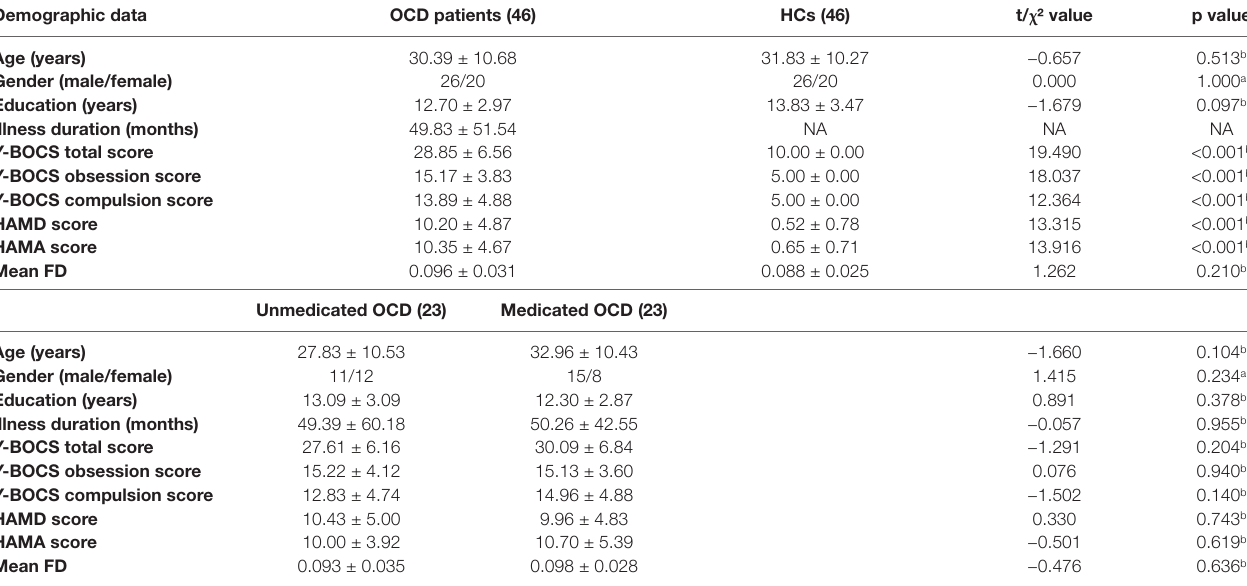
TABLE 1 | Demographic and clinical characteristics of